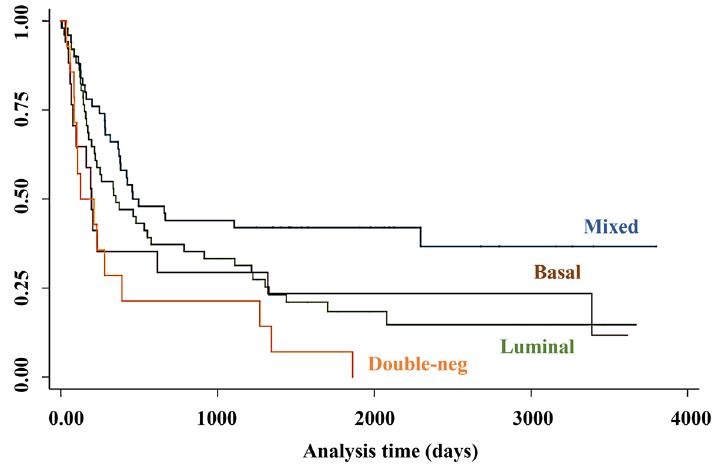
Figure 4. Kaplan–Meier survival curves of patients with different molecular subtypes of muscle-invasive bladder cancer according to their immunoexpression of four